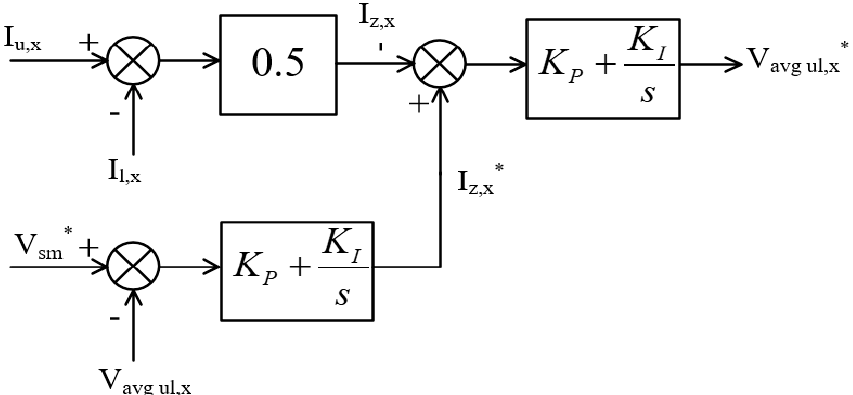
Figure 3. A block diagram of the implemented phase averaging controller.